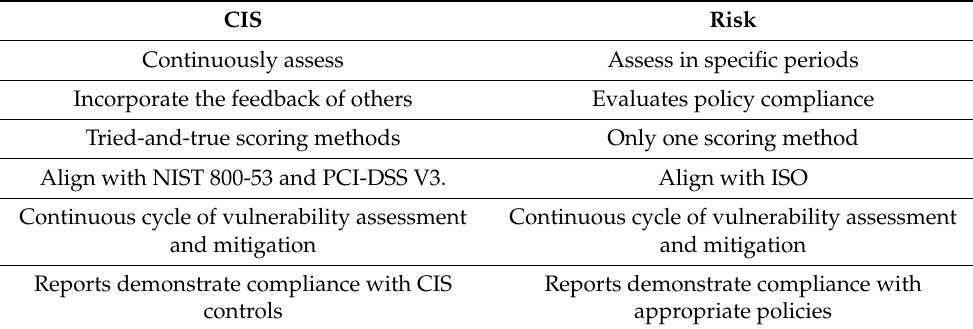
Table 27. CIS versus risk compliance. CIS Risk Continuously assess Assess in specific periods Incorporate the feedback of others Evaluates policy compliance Tried-and-true scoring methods Only one scoring method Align with NIST 800-53 and PCI-DSS V3. Align with